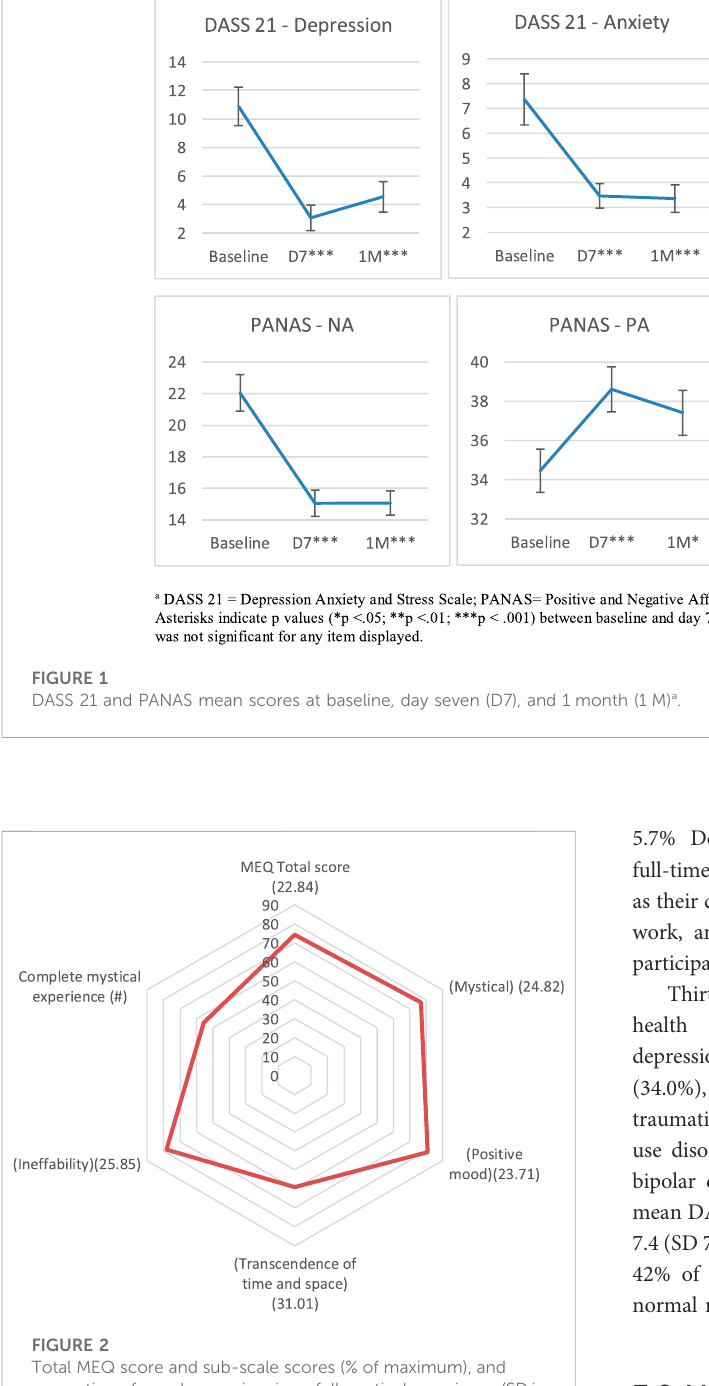
FIGURE 2 Total MEQ score and sub-scale scores (% of maximum), and proportionofpeopleexperiencingafullmysticalexperience(SDin